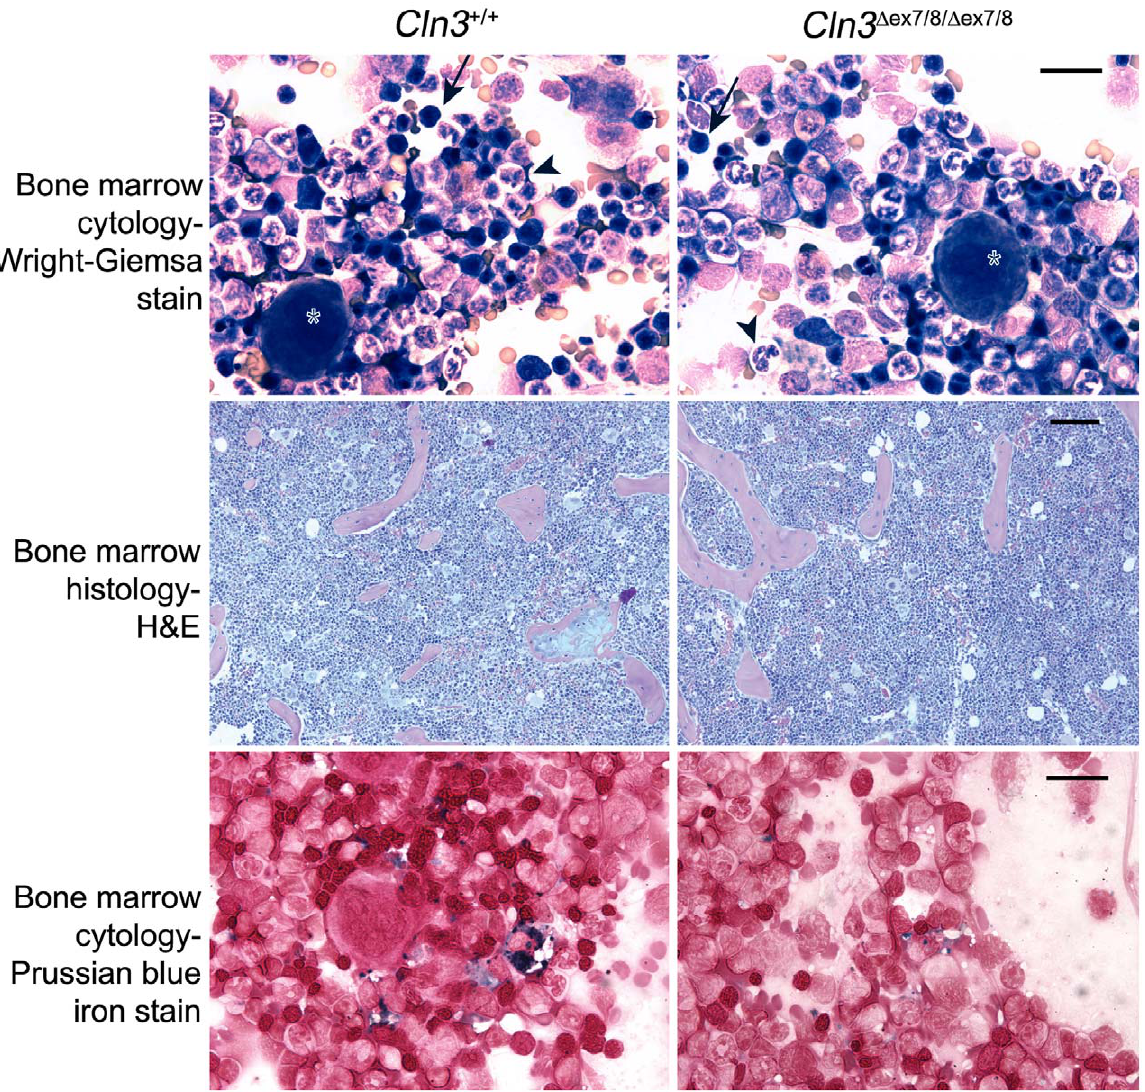
Figure 6. Bone marrow analysis of Cln3 D ex7/8 mice. Representative images are shown of Wright-Giemsa-stained bone marrow brush cytology, H&E stained sections of formalin-fixed, paraffin embedded tibias, and iron stained brush cytology, from wild-type ( Cln3 + / + ) and homozygous mutant ( Cln3 D ex7/8/ D ex7/8 ) mice (n=3 mice per genotype). Stained iron appears blue. Note the reduced amount of stained iron in Cln3 D ex7/8/ D ex7/8 marrow, compared to wild-type marrow. Arrow, erythroid element; arrowhead, myeloid element; asterisk, megakaryocyte. Scale bars, top and bottom panels=25 m m; middle panels=100 m m.